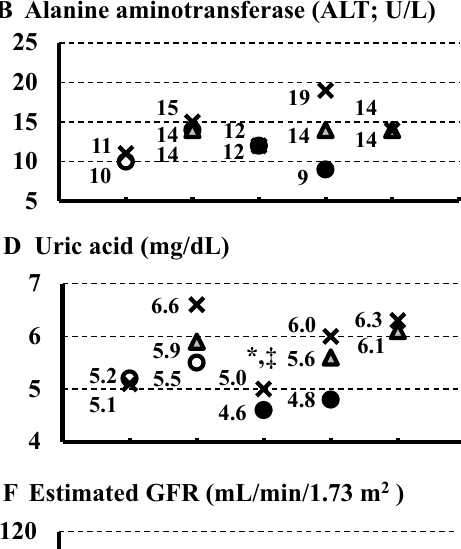
, at GH onset (appearance ●